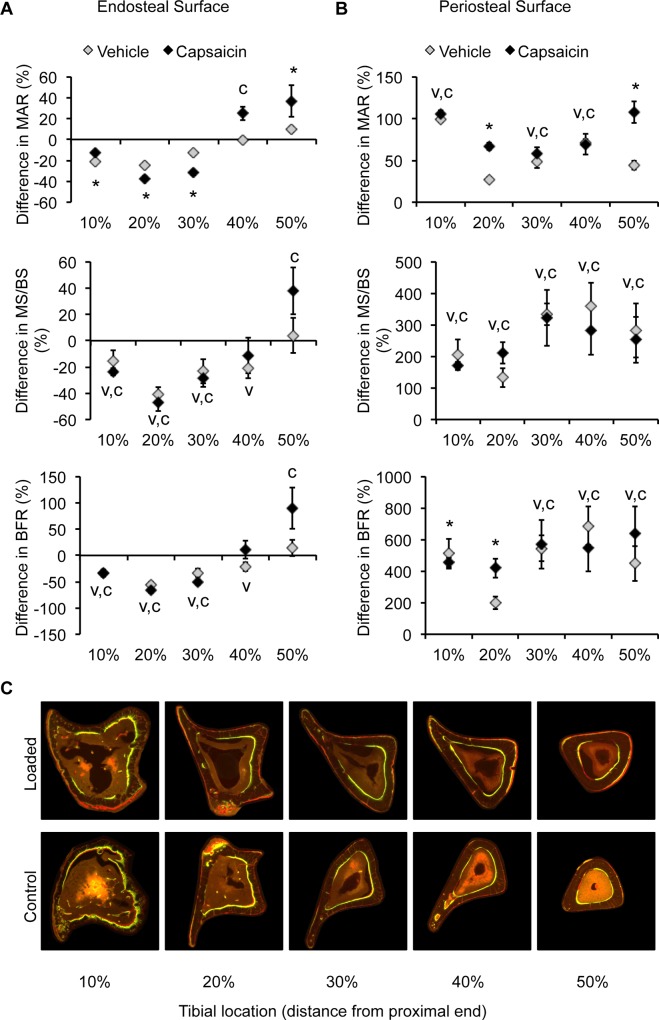
Dynamic histomorphometric analysis of bone formation in capsaicin- and vehicle-treated mice.Mineral apposition rate (MAR), percent mineralizing surface (MS/BS), and bone formation rate (BFR/BS) were quantified for the endosteal (A) and periosteal surfaces (B) in mice loaded with tibial compression at 7 N magnitude. Fluorescent images (C) show cortical bone from the control and loaded tibias of a vehicle-treated mouse. V: loading caused a significant difference in tibias of vehicle-treated mice, p<0.05. C: loading caused a significant difference in tibias of capsaicin-treated mice, p<0.05. *: the response was significantly different between vehicle- and capsaicin-treated mice.